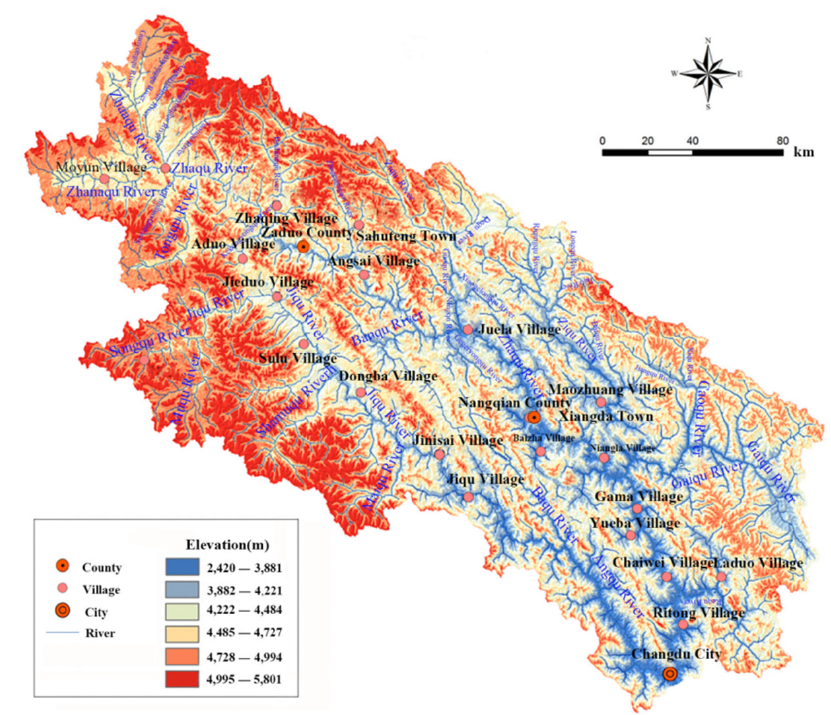
Figure 2. Hydrological map of the upper Lancang River.